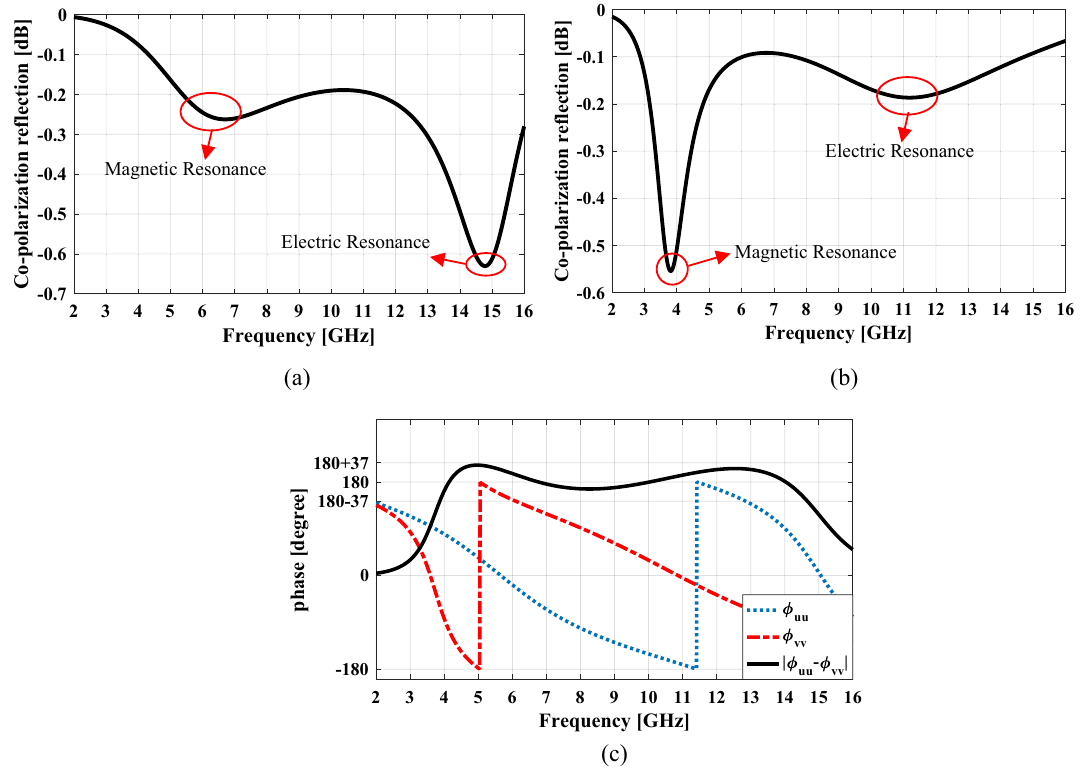
Figure 2. The four eigenmodes of the double-head arrow under normal incidence: ( a ) v-polarized case and ( b ) u-polarized case ( c ) the phase of the reflected wave in u-polarization, v-polarization and the phase difference between